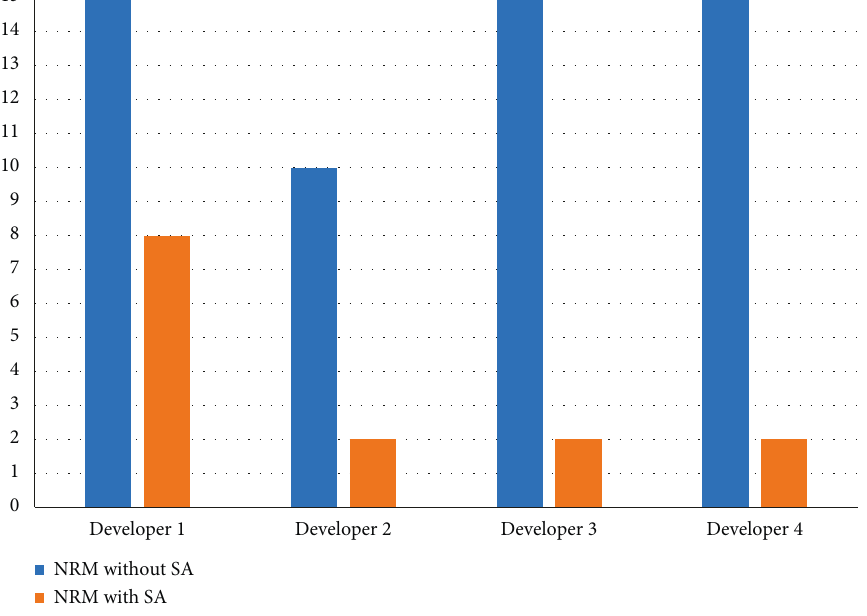
Figure 5: Comparison of NRM with SA status.